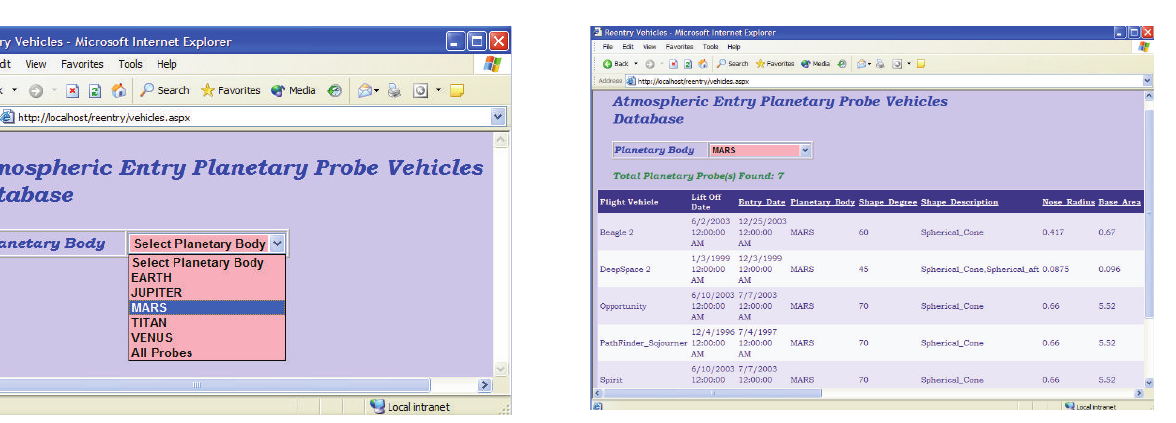
Figure 9: Atmospheric entry DOTNET web user interface. Figure 10: Atmospheric entry planetary vehicle web